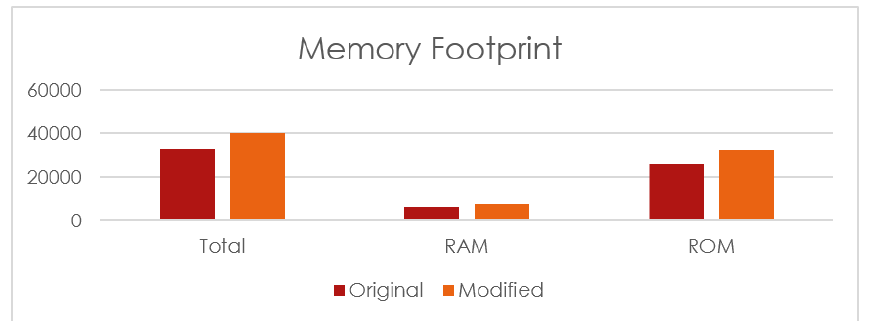
Figure 19. Memory footprint for the program on an OpenMote.